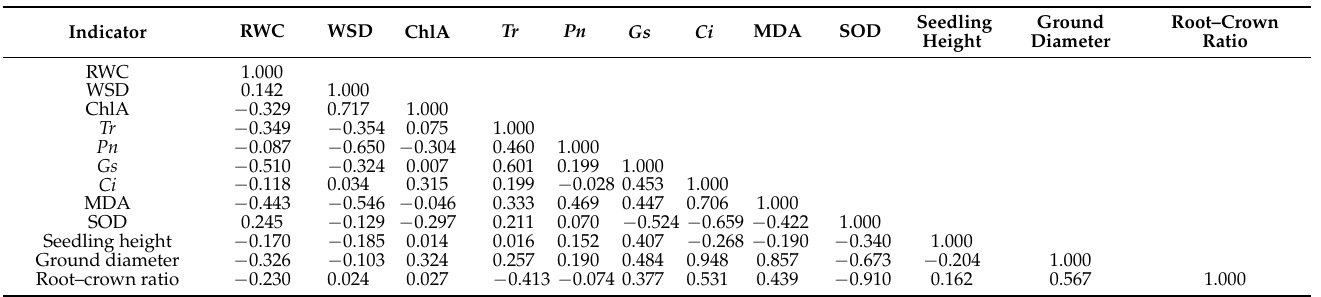
Table A1. Correlation analysis of the drought resistance coefficients of each index under mild drought stress.